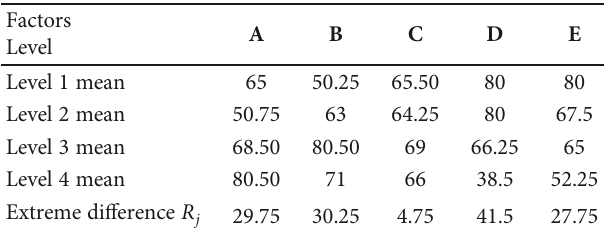
Figure 2: Slag photos of hole exit at × 100 magni fi cation (No. 4 (a), No. 8 (b), and No. 16 (c)). Table 4: Analysis table of orthogonal